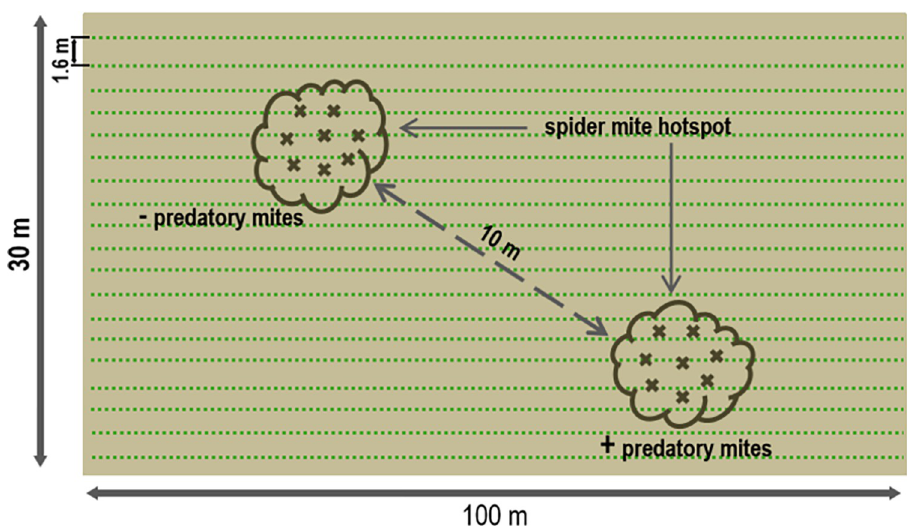
Fig 2. Schematic representation of spider mite hotspots in a trial plot. Visually detectable spider mite hotspots were analysed 2020 and 2021. Two spider mite hotspots were sampled per trial plot. One hotspot was treated with predatory mites ( Neoseiulus californicus (Acari: Phytoseiidae) (McGregor)) (+ predatory mites), the second remained untreated and served as a control (- predatory mites). Hotspots had a minimum spacing of 10 m and a diameter of approximately 6 m. Crosses indicate sampling points for soil and